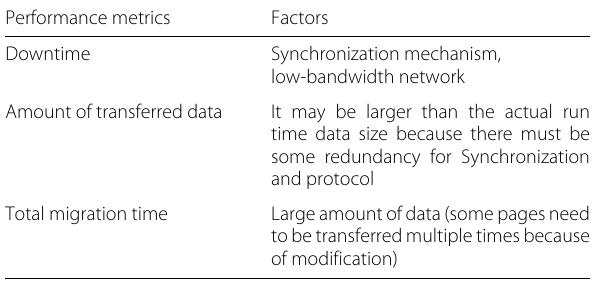
Table 2 Factors impacting the metrics Performance